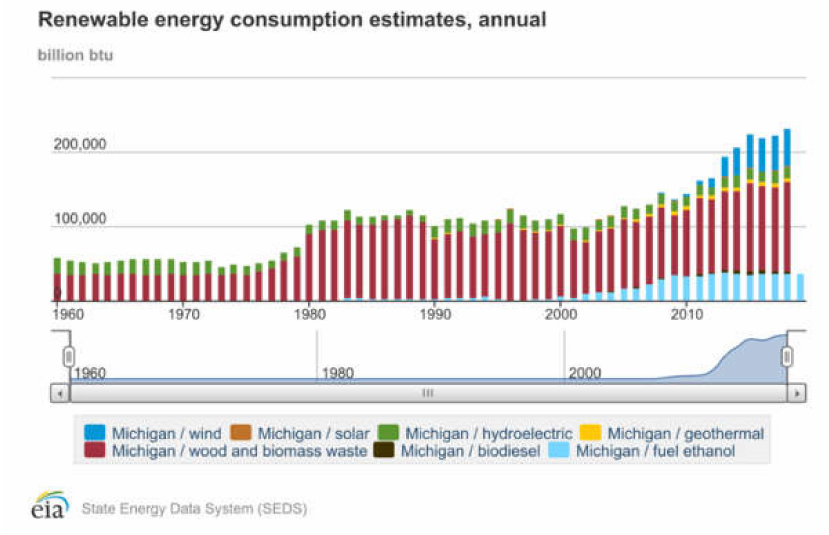
Figure 2. Michigan Renewable Energy Consumption Estimates. Source: US Energy Information Administration. https://www.eia.gov/state/search/#?1=104&2=203&a=true&r=false, accessed on 18 November